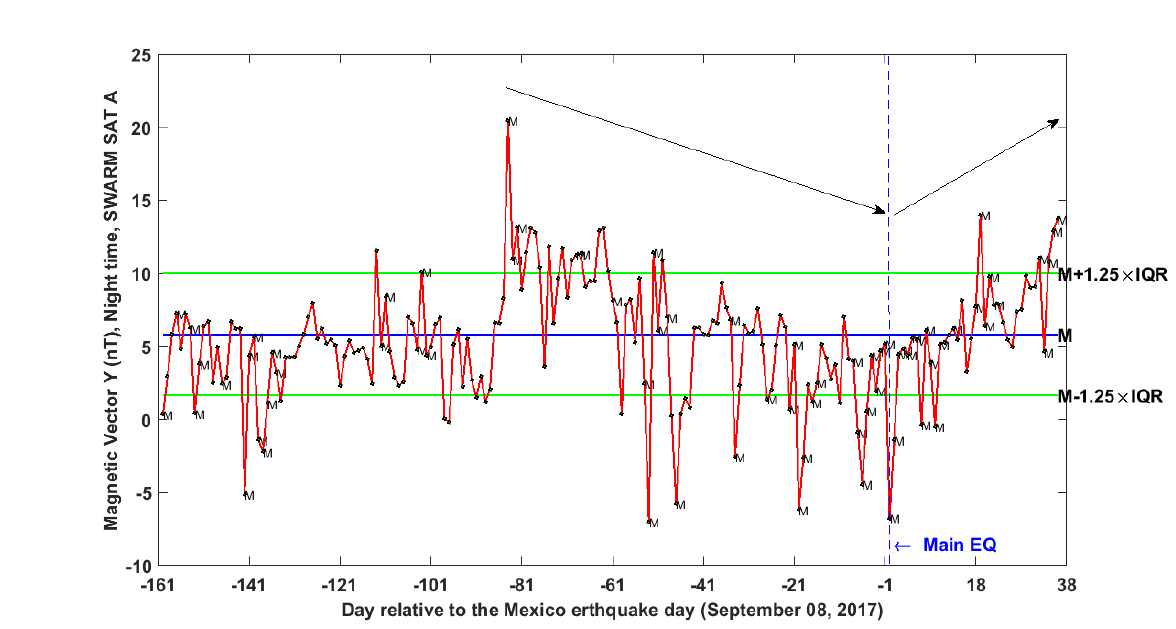
Fig. 2. Same as Fig. 1 but the y-axis represents the night time vector Y magnetic field median values for each day.